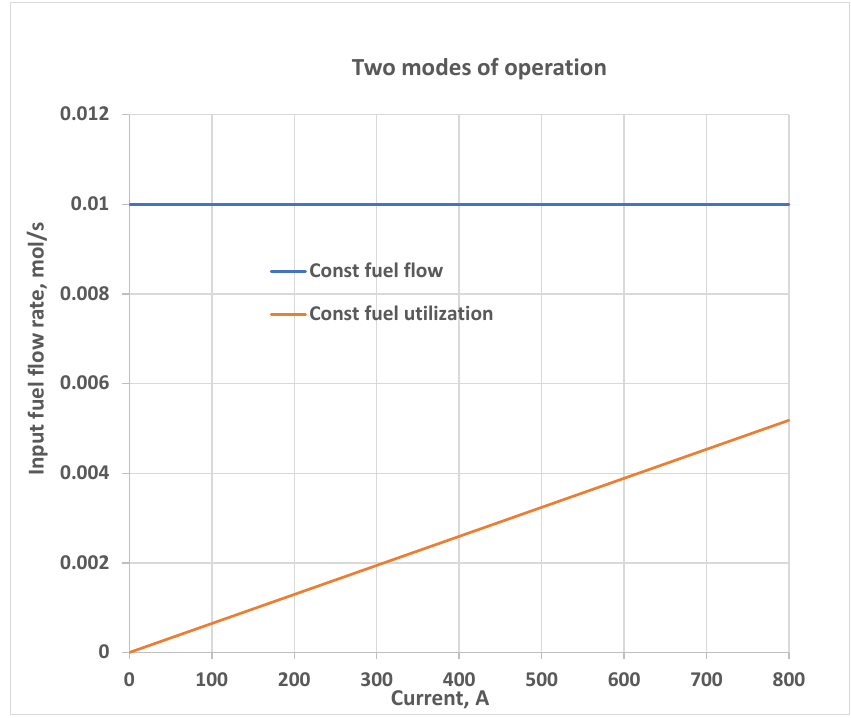
Figure 5. Variation in the input fuel flow rate with current in the two modes of operation: no variation (constant fuel flow mode) and linear variation (constant fuel utilization